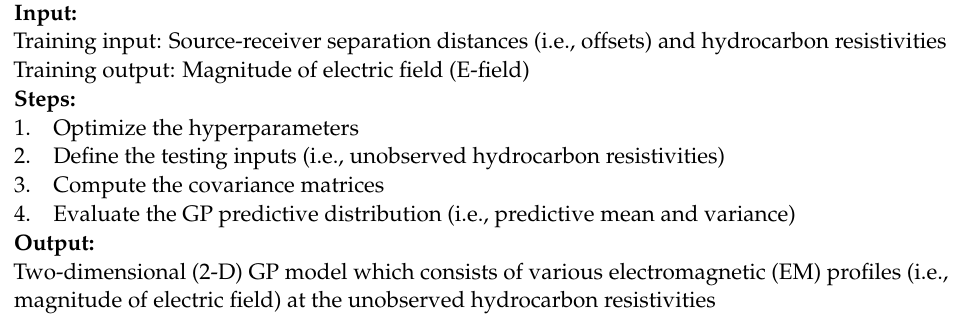
Algorithm 1 Forward Gaussian Process (GP) Modeling